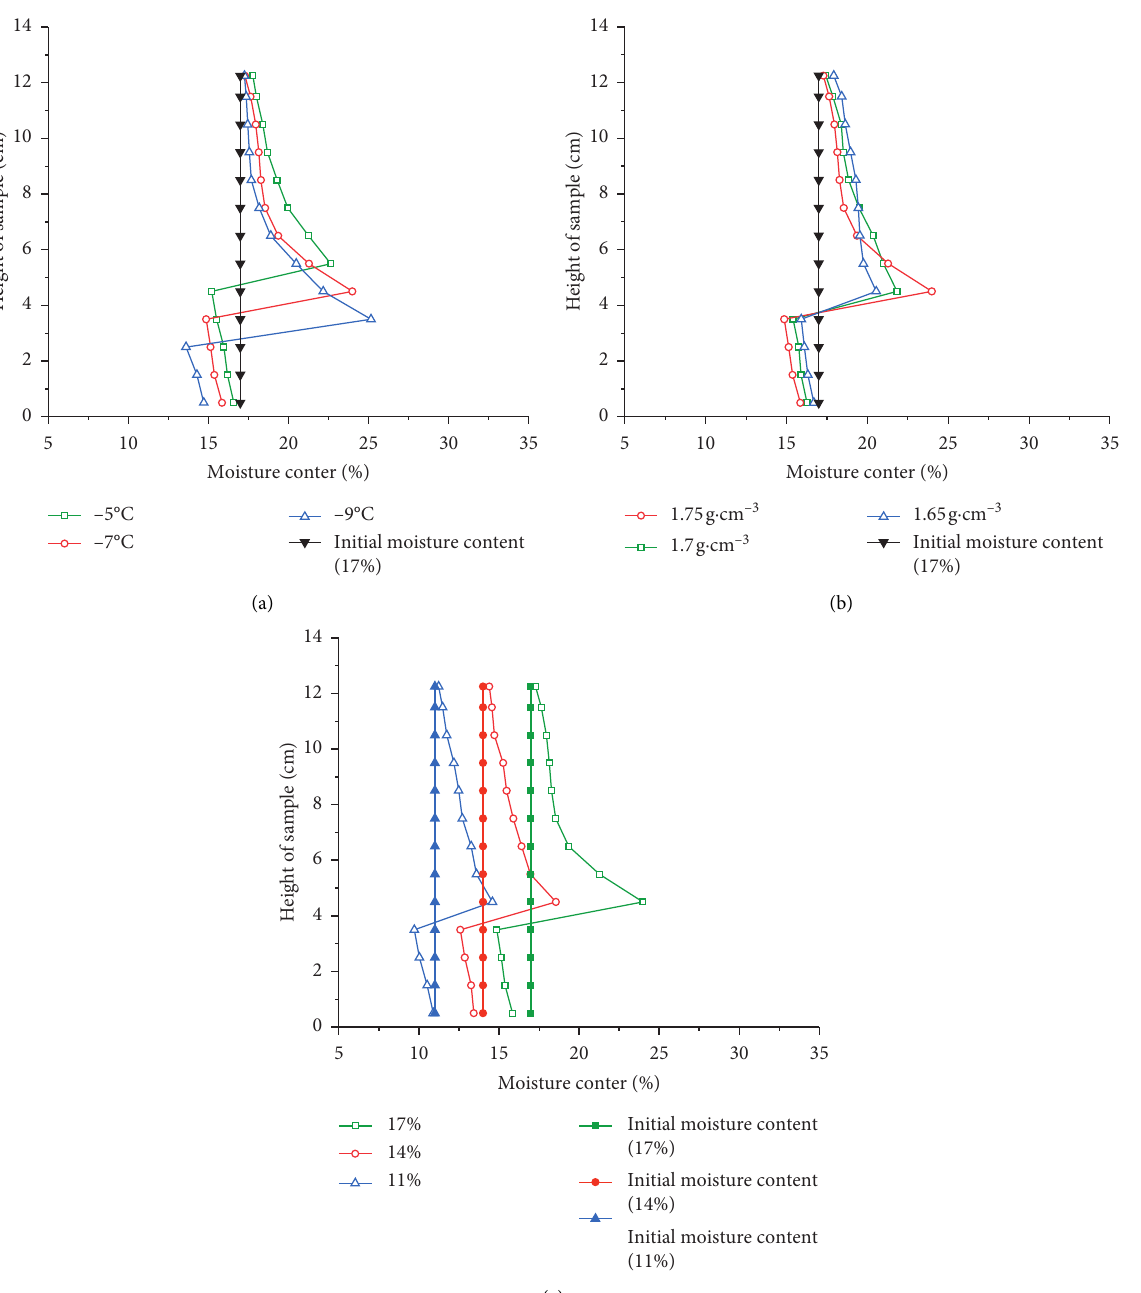
Figure 9: Variation of moisture content in soil samples under (a) different top-plate temperatures, (b) dry densities, and (c) initial moisture contents after the freezing